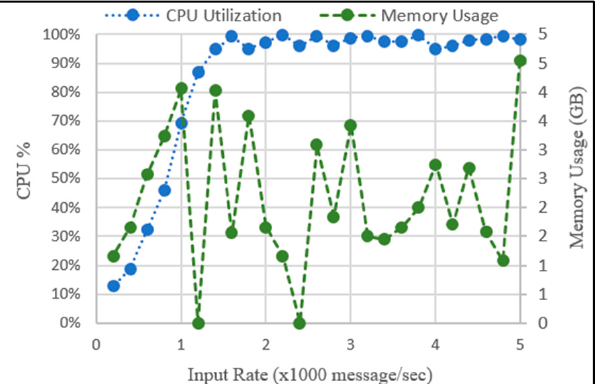
Figure 28. Throughput vs. input rate.